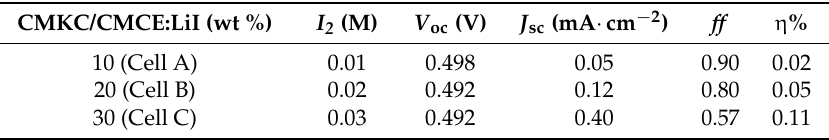
Figure 7. Photocurrent density-voltage for DSSC. Table 4. J – V performance of FTO/TiO 2 /Electrolyte+I 2 /pt/FTO.